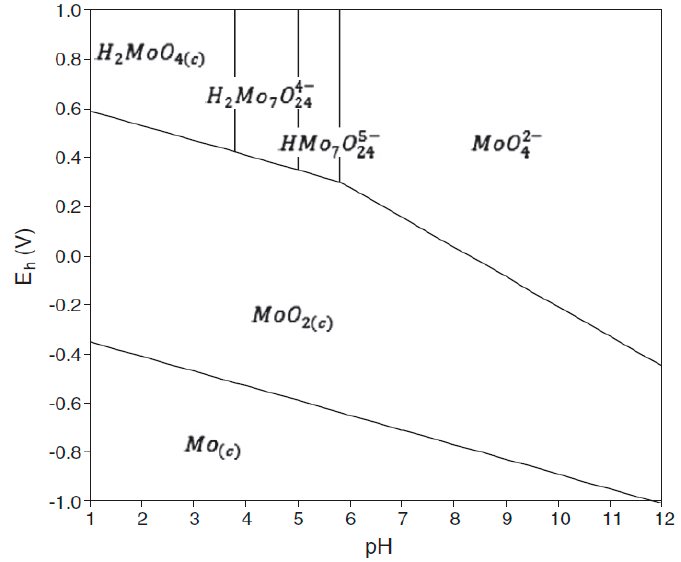
Figure 9. Molybdenum ionic species as a function of pH [8], License No.:5250091421412.